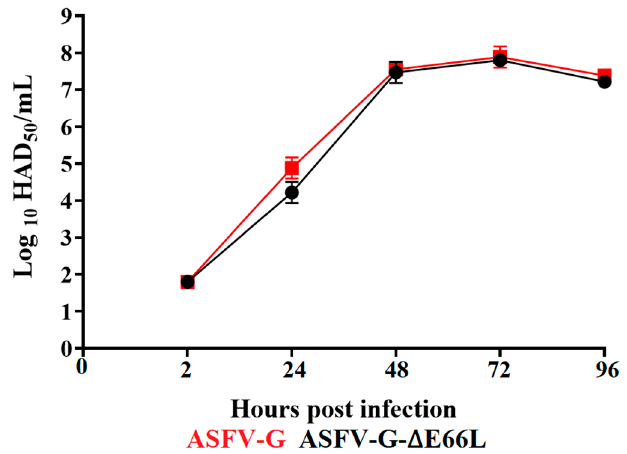
Figure 3. In vitro growth kinetics in primary swine macrophage cell cultures for ASFV-G- ∆ E66L and parental ASFV-G (MOI = 0.01). Samples were taken from three independent experiments at the indicated time points and titrated. Data represent means and standard deviations of the virus titers. Sensitivity using this methodology for detecting virus is ≥ log10 1.8 HAD 50 /mL. No significant differences in viral yields between viruses were observed at any time point tested using the two-stage set-up (Benjamini, Krieger, and Yekutieli) method .